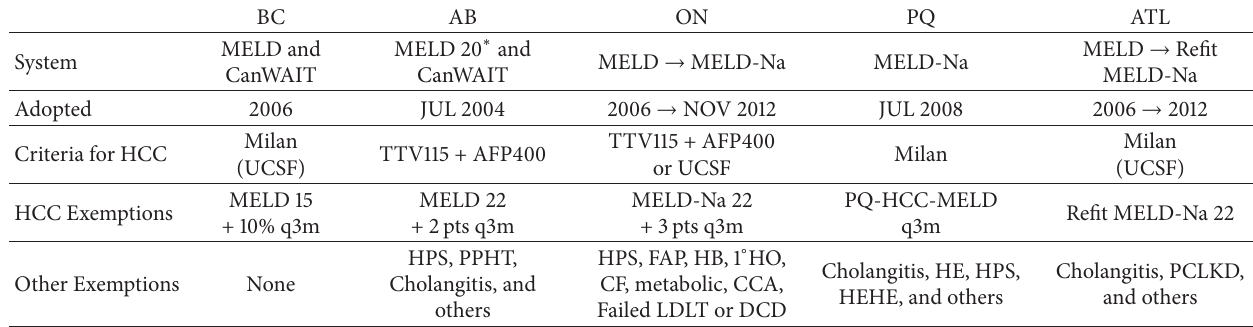
Table 5: Survey of MELD use in Canada (October